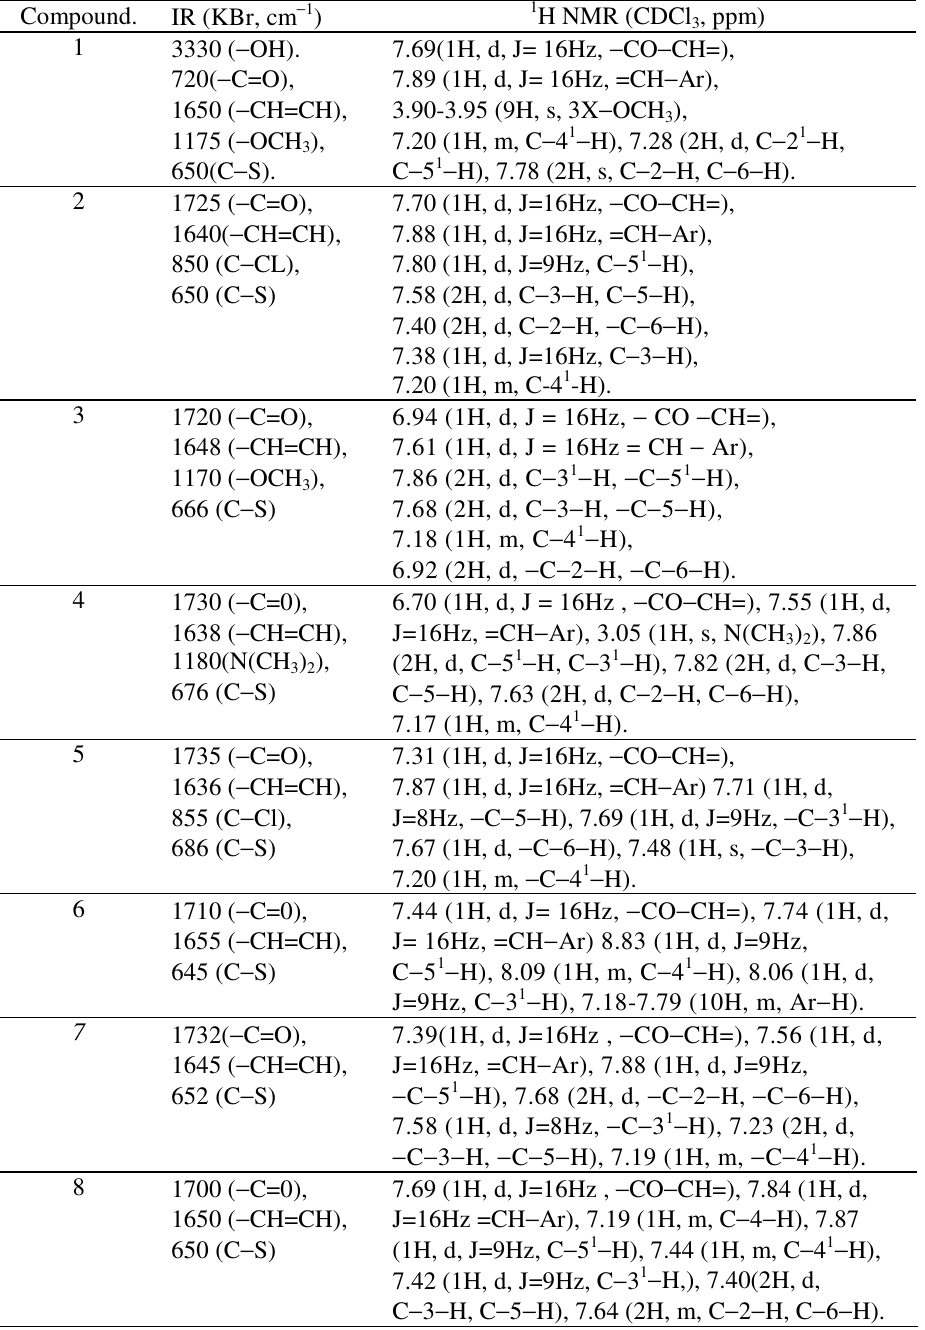
Table 2. Spectral data of the compounds ( 1-8